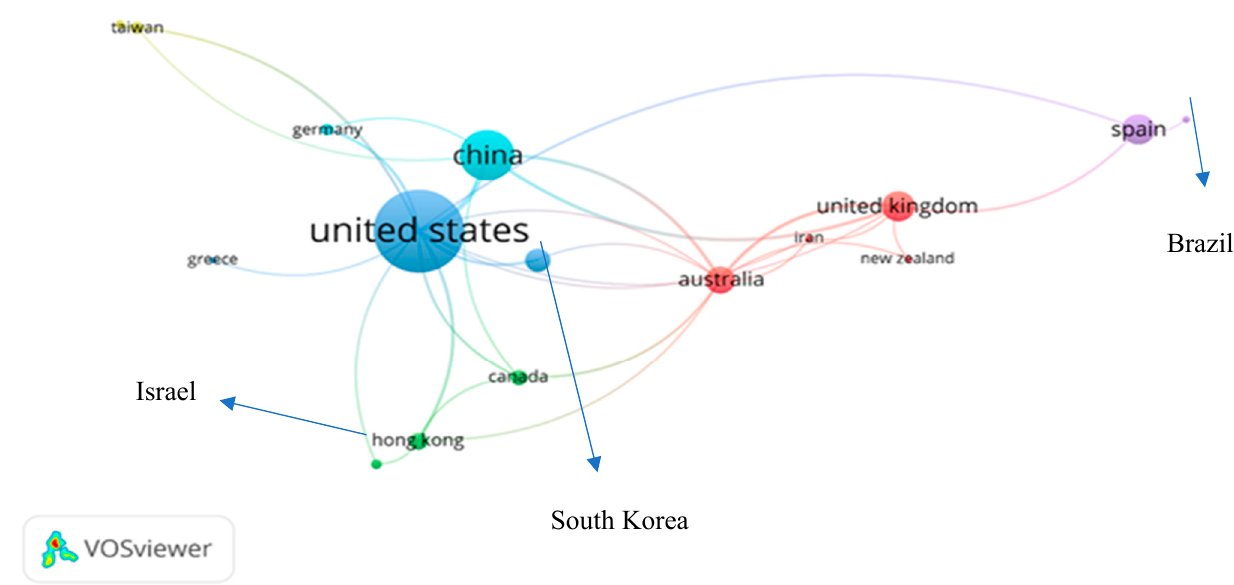
Figure 4. The geospatial collaboration network in research on DTs in the AEC industry.